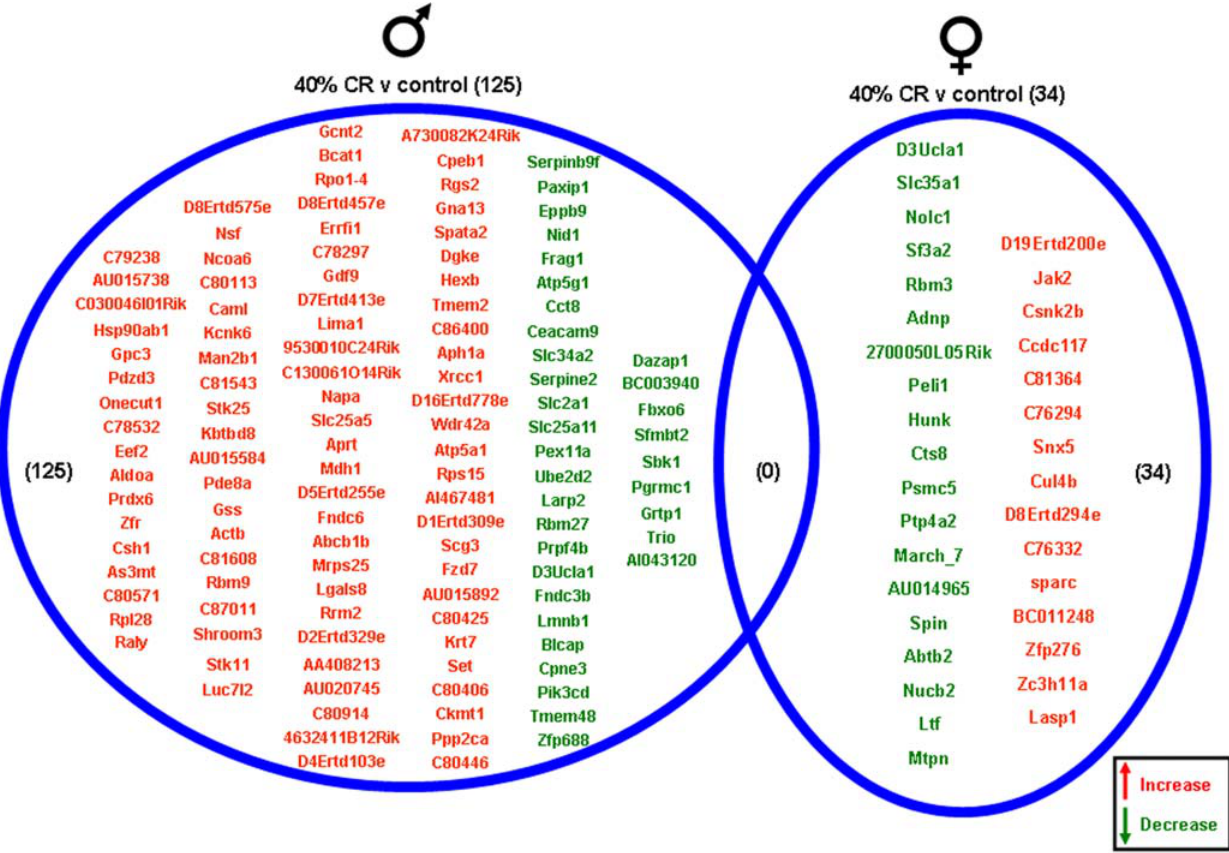
Figure 5. Hippocampi of male and female rats maintained on a 40% CR diet were compared to the hippocampi of rats maintained on a control ( adlibitum ) diet. Genes that were significantly up-regulated (red) or down-regulated (green) were clustered into a Venn diagram. There were 91 significantly up-regulated and 34 significantly down-regulated genes in the hippocampi collected from 40% CR male rats compared to the genes from hippocampi collected from control ( ad libitum ) male rats. Hippocampi collected from 40% CR female rats showed 15 significantly up- regulated (red) and 19 significantly down-regulated (green) genes compared to the hippocampi collected from control ( ad libitum ) female rats. There were no significantly up-regulated or down-regulated common genes between male and female rats in this dietary group. Names of the significantly altered genes can be found in Table S1.